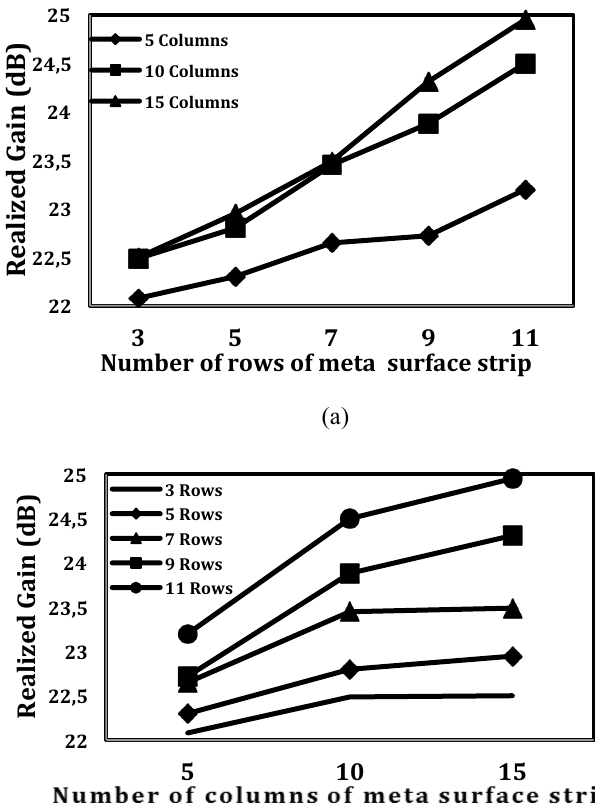
of horn Antenna with and without meta surface